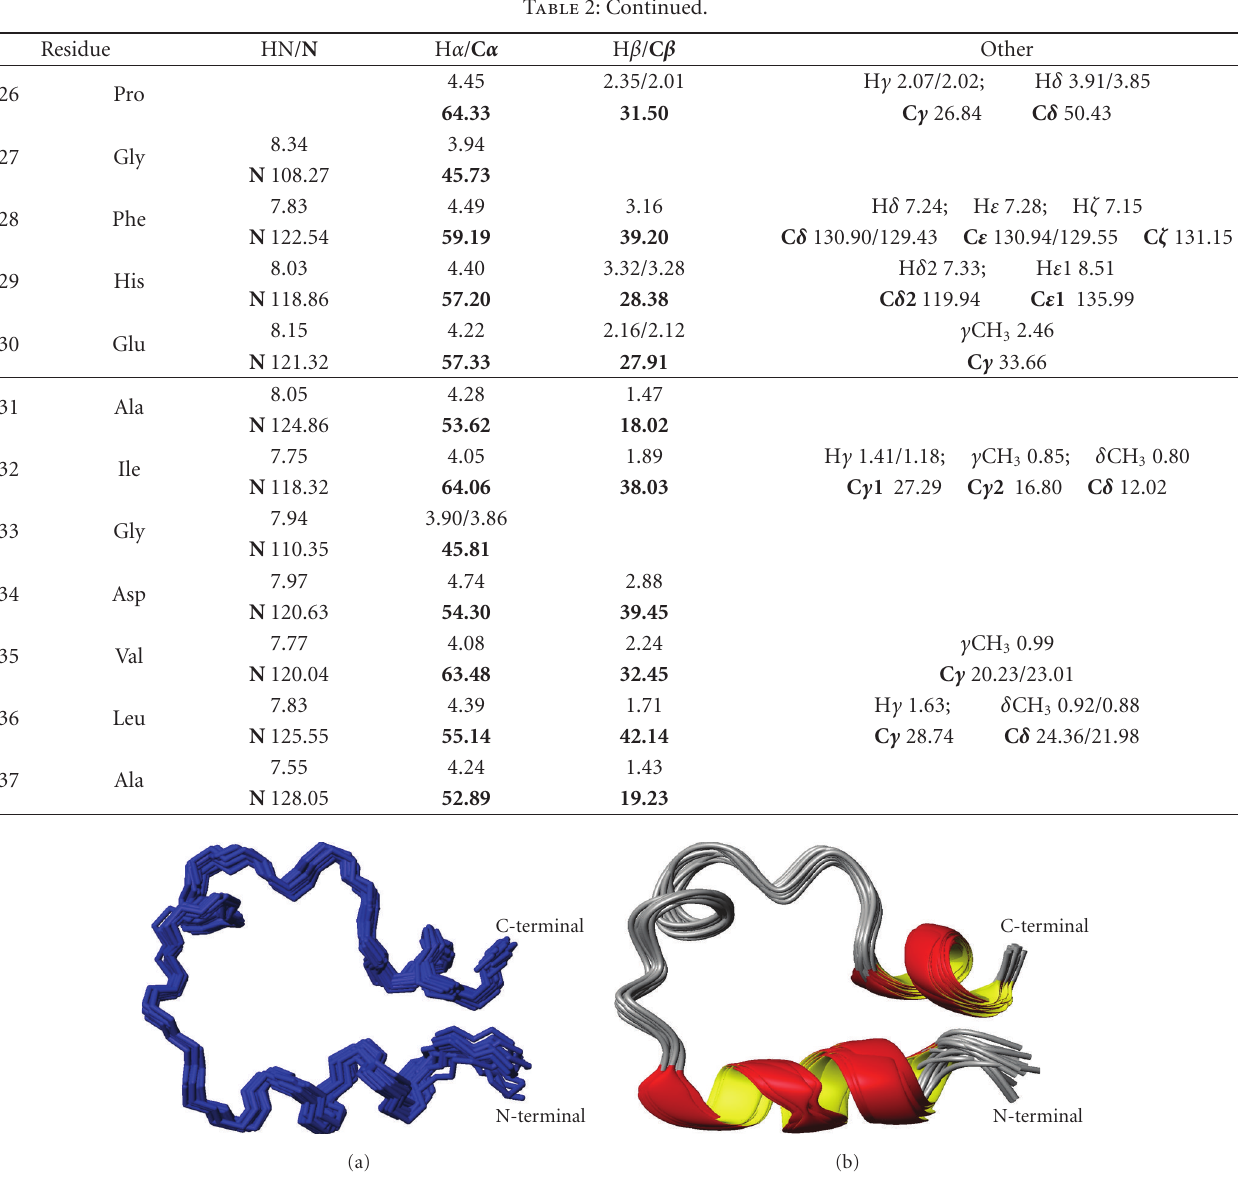
Figure 6: (a) Ensemble of DYANA 30 best models of the Zn 2+ -ACE N (37) (corresponds to His 360 -Ala 396 of the human somatic form) calculated with NMR data. (b) Ribbon diagram of Zn 2+ -ACE N (37) peptide.